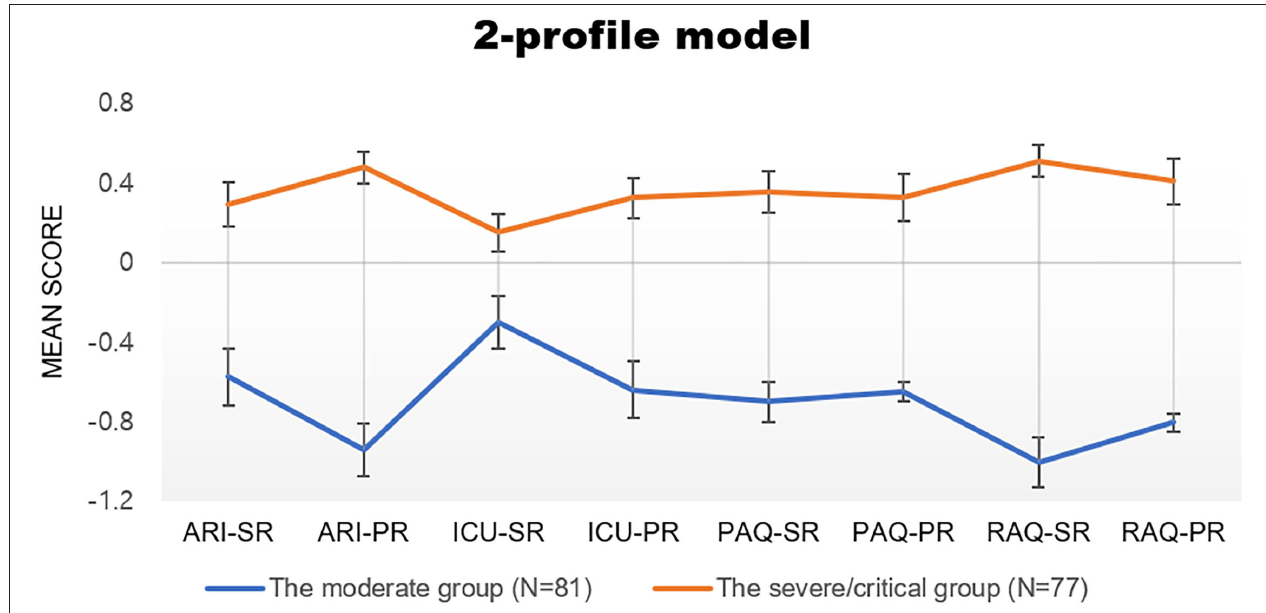
FIGURE 1 | Mean score of class membership at baseline in each latent class. ARI-SR, ARI-PR, ICU-SR, ICU-PR, PAQ-SR, PAQ-PR, RAQ-SR, and RAQ-PR refer to indicators for LPA of aggression, irritability and callous-unemotional traits reported by youth and their caregivers. ARI, Affective Reactivity Index; AQ,